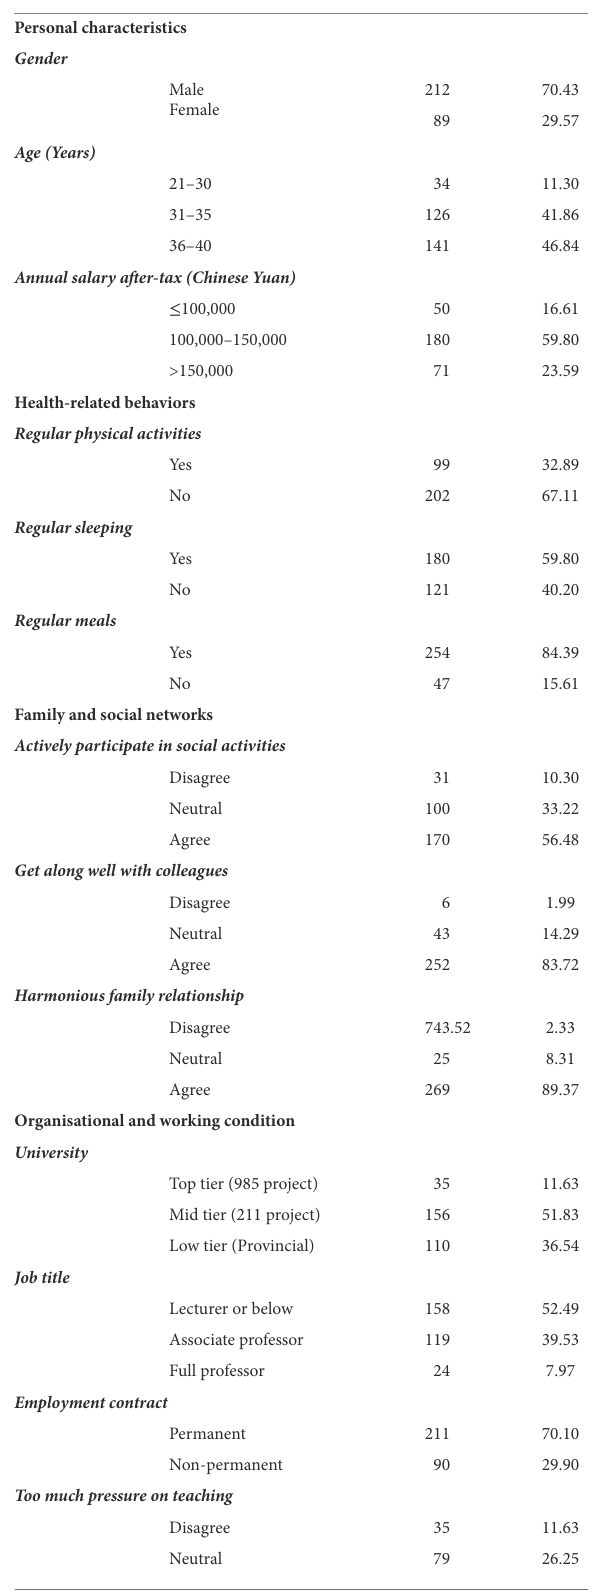
TABLE 1 Characteristics of respondents ( n =